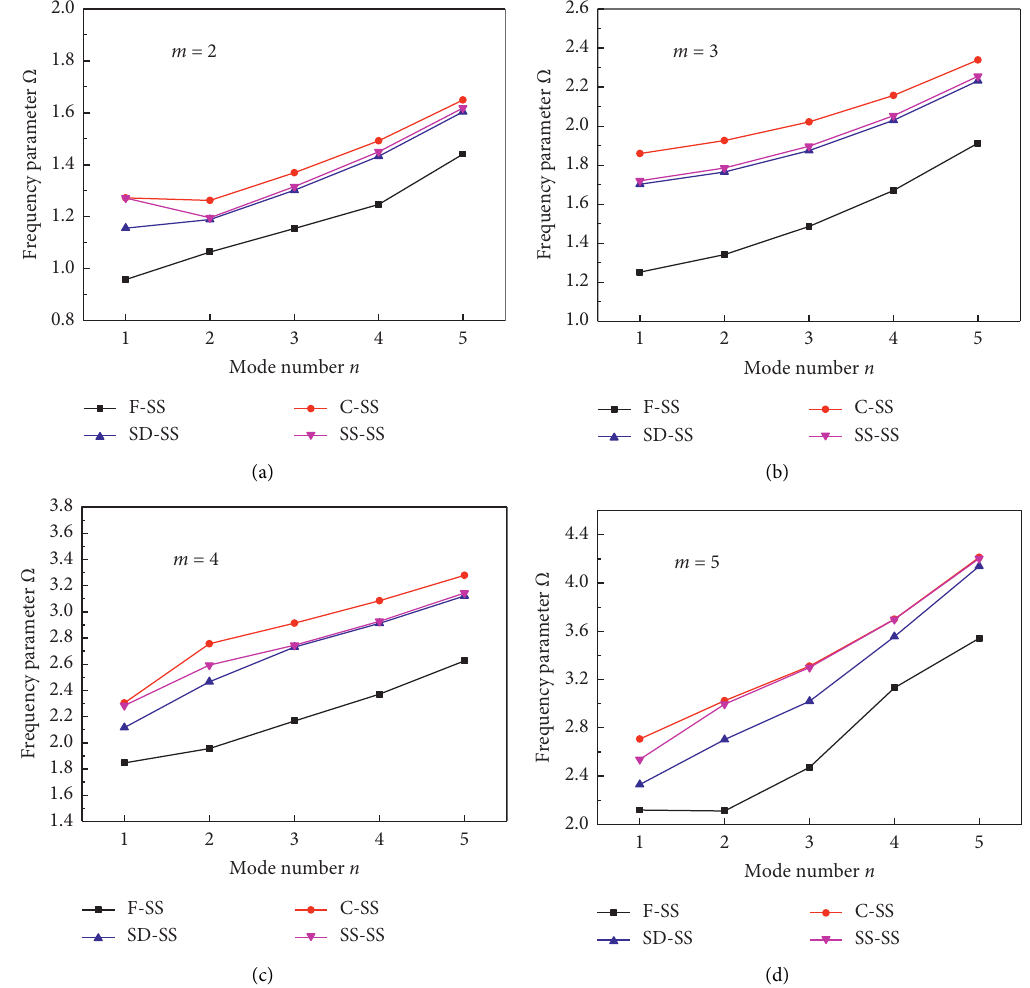
Figure 6: Frequency parameters Ω of the annular spherical shell with different boundary